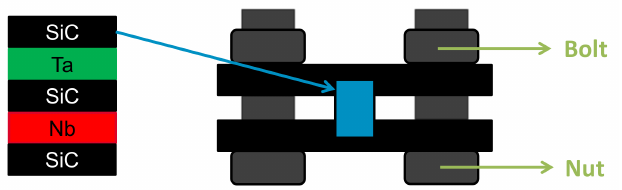
Figure 5. Diffusion couple experiments